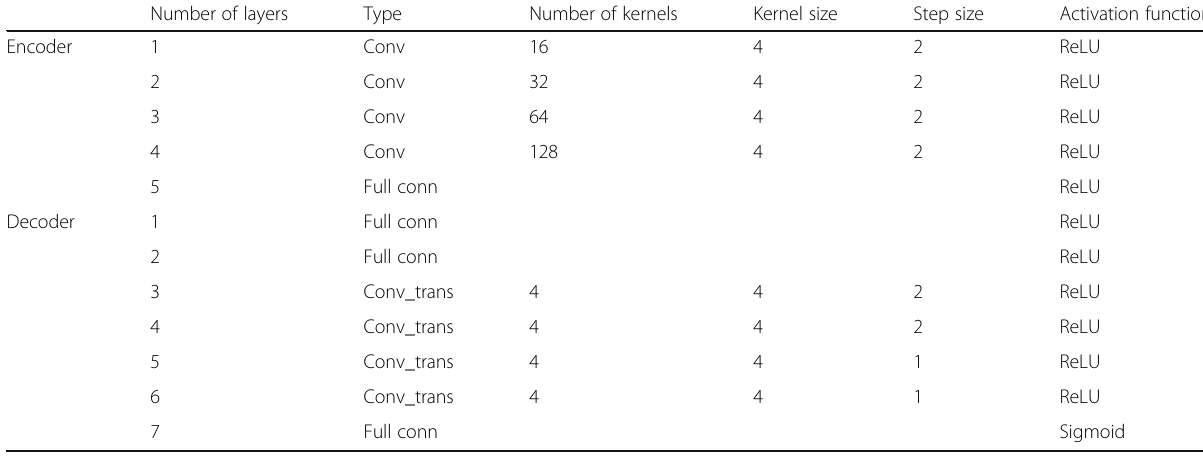
Table 1 Variational auto-encoder model construction details Number of layers